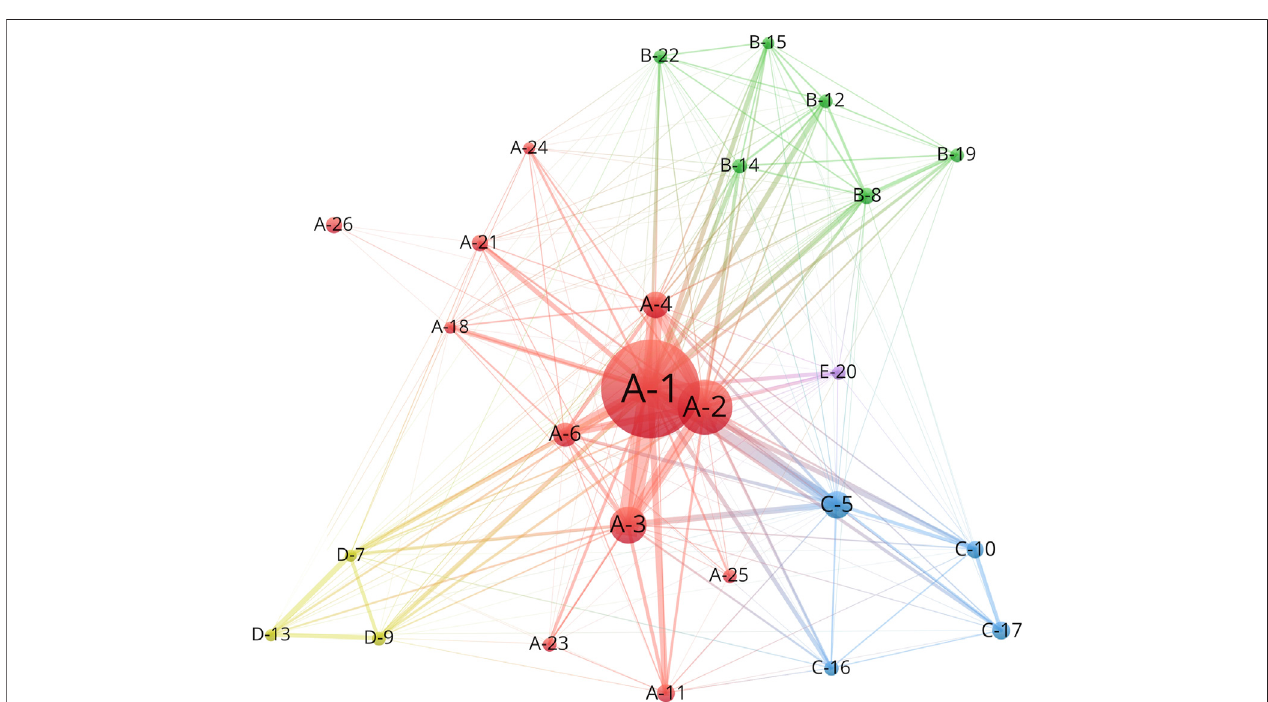
FIGURE 5 | Main journal sources: a bibliographic coupling network visualization, with each node representing a journal source ( Table 5 ).